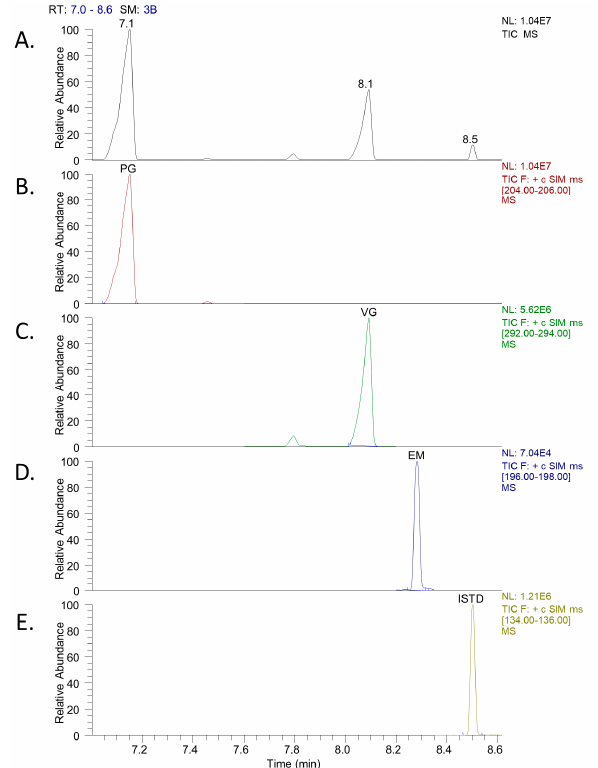
Figure 1. ( A ). Total ion current chromatogram of PG, VG, EM, and ISTD using GC-MS. ( B – E ). Extracted ion chromatograms of PG ( m / z 205), VG ( m / z 293), EM ( m / z 197), and ISTD ( m / z 135). To ensure that the concentration of EM was not affected by the different matrices (dif- ferent ratios of PG/VG in each calibration point), EM at a concentration of 0.3 mg/mL was spiked in the tested ratios of PG/VG (100/0, 80/20, 70/30, 50/50, 30/70, and 0/100), and the samples were analyzed according to the described methodology. The %RSD of the EM in the examined samples ( n = 6) was 1.3%, indicating that the ratio of PG/VG did not affect the dilution of EM. Therefore, the combination of calibration points did not result in fault results. Furthermore, the proposed methodology did not require prior knowledge of the PG/VG ratio in e-liquids for the analysis of EM. A blank chromatogram after the addition of derivatization agents and the ISTD is given in Figure S1 (Supplementary Material). For the second method, the PG/VG ratio of 50/50 was selected as the matrix for the calibration curve of nicotine. The %RSD of nicotine (9 mg/mL, n = 6) was 2.1% in different ratios of PG/VG; thus, one ratio of PG/VG was selected to simplify the